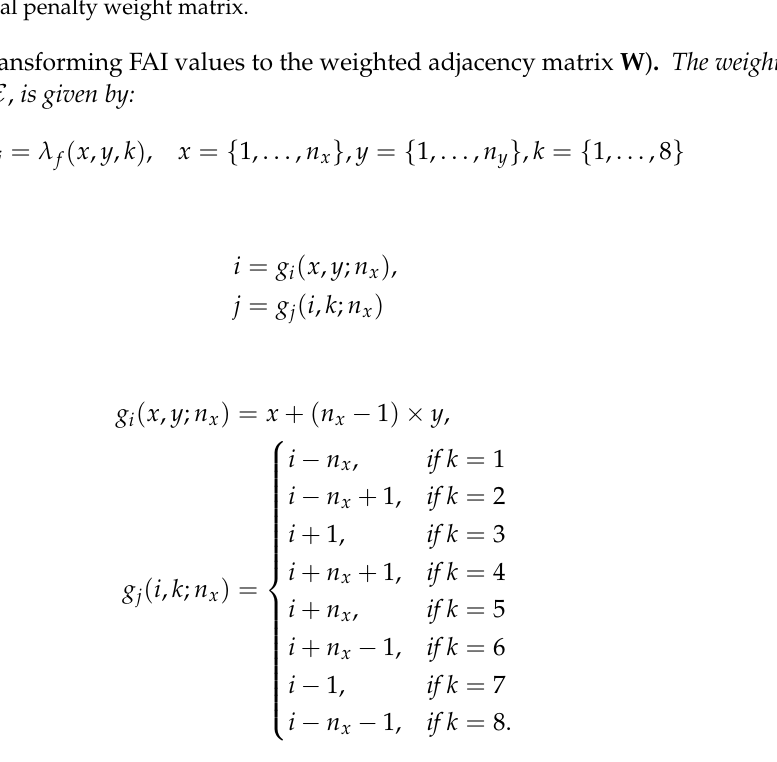
Figure 5. Left : Representation of the King’s graph, with FAI as the cost of the edges. Right : Physics- inspired directional penalty weight